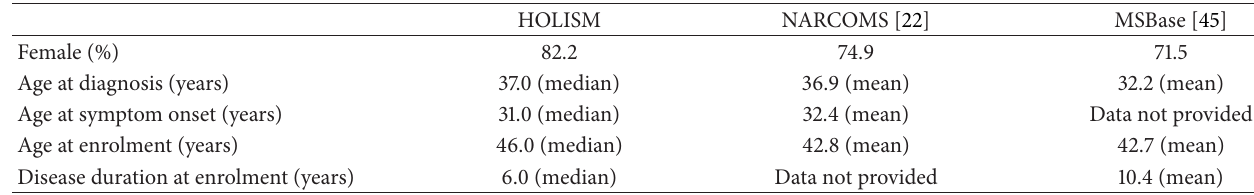
Table 9: Comparison of data with NARCOMS and MSBase